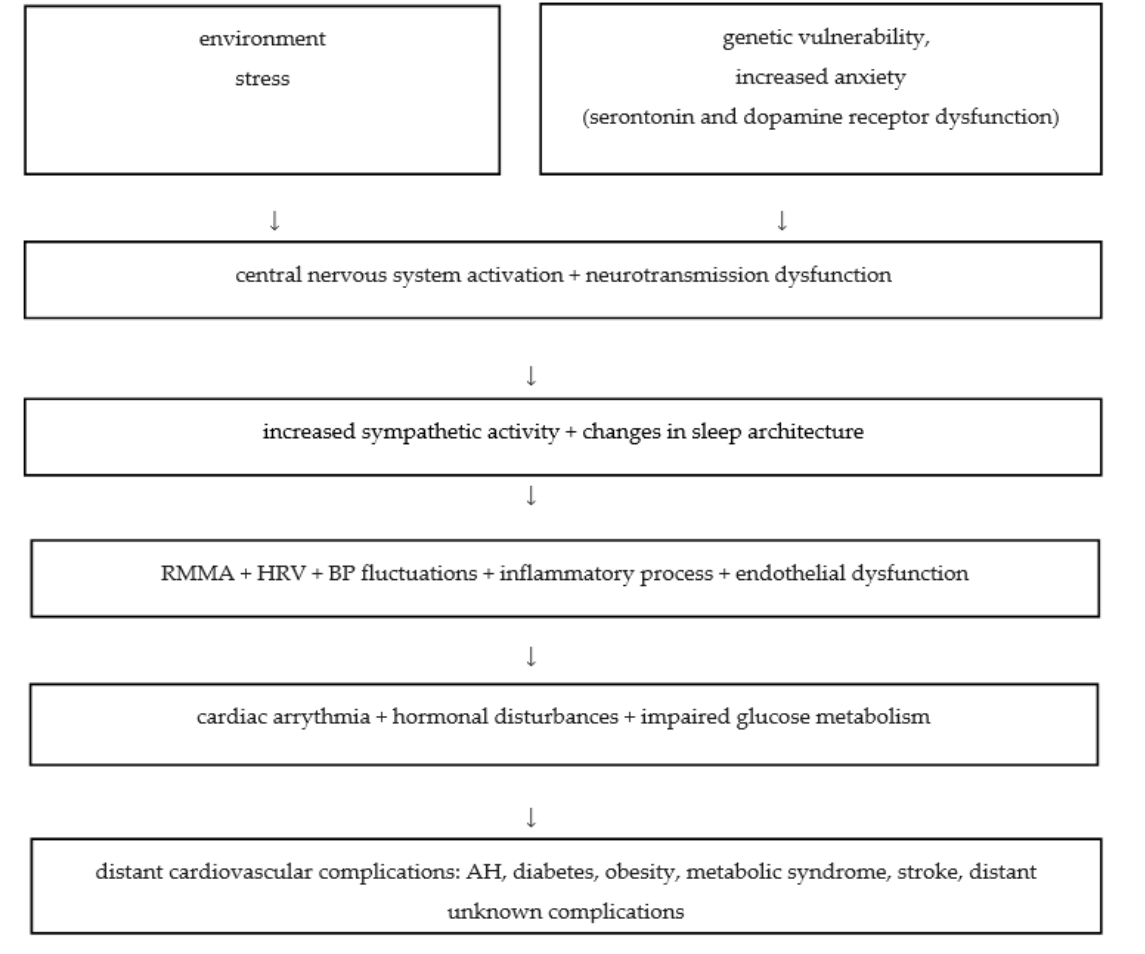
Figure 2. A possible cause-and-effect diagram of local and overall cardiovascular consequences of sleep bruxism. RMMA, rhythmic masticatory muscles activity; HRV, heart rate variability; BP, blood pressure; AH, arterial hypertension.